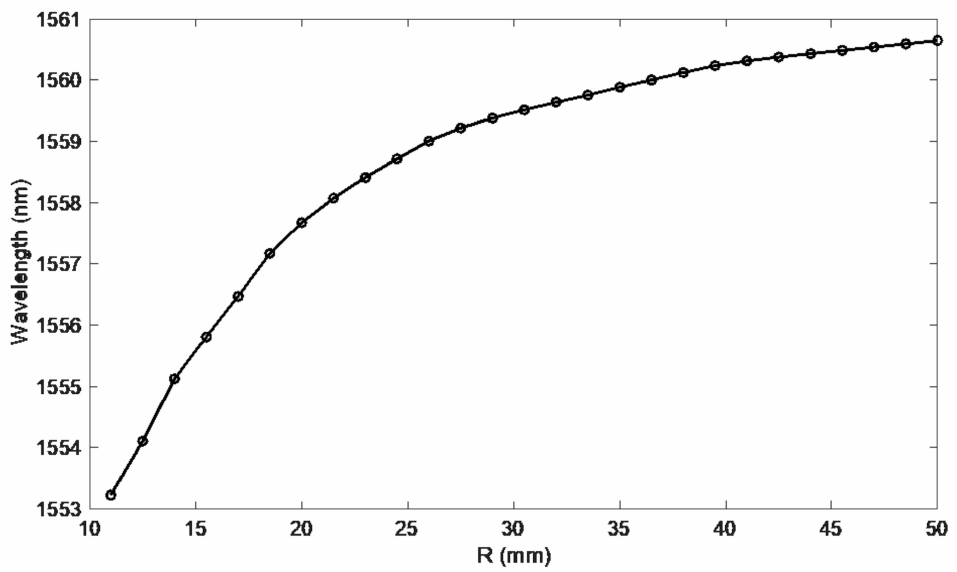
Figure 8. Mode leak wavelengths versus bending